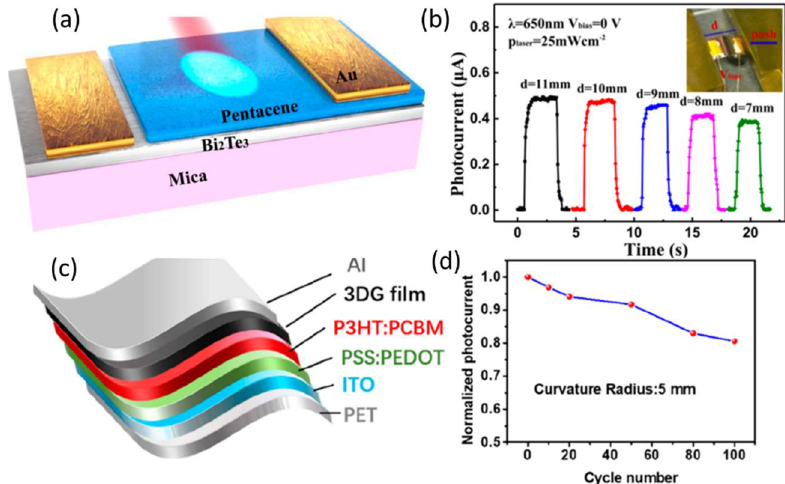
Figure 9. ( a ) The structure diagram of Bi 2 Te 3 /pentacene heterostructure self-powered PD, ( b ) the distance between two ends and photocurrent diagram of PDs under irradiation of 650 nm, reprinted with permission from [154] ©2019 ACS Publications. ( c ) schematic of the flexible 3DG film/OPD, and ( d ) normalized photocurrent for flexible 3DG film/OPD as a function of cycle number of repeated bending to a radius of 5 mm reprinted with permission from [50] ©2022 ACS Publications.